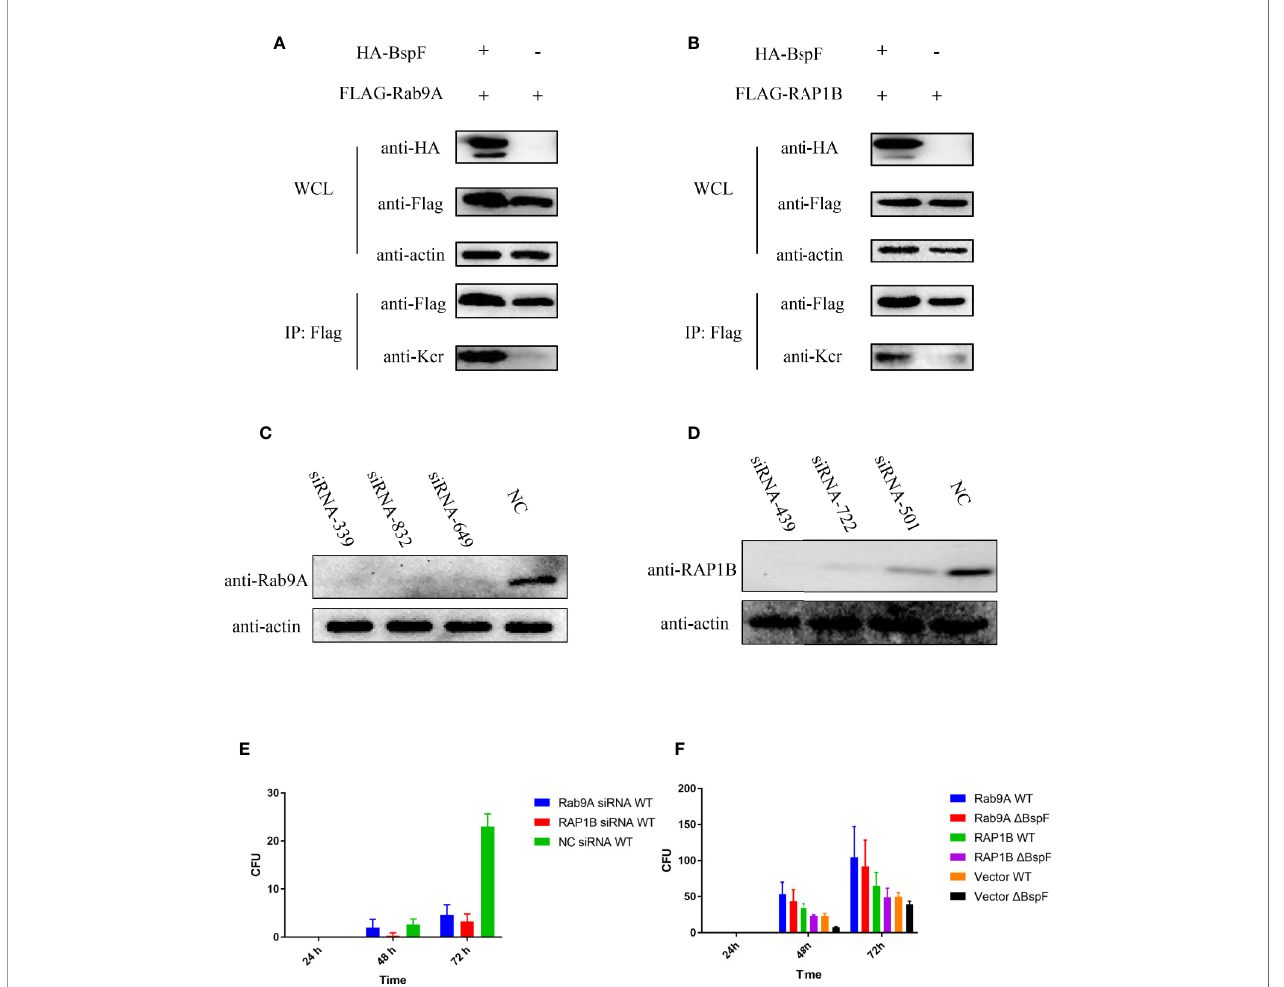
FIGURE 6 | The crotonylated proteins in the crotonylation proteomics data have in fl uence the survival of Brucella. Veri fi cation of the accuracy of proteomics data (A – B) BspF causing the crotonylation of Rab9A and RAP1B. (C – D) Silencing ef fi ciency of siRNA to Rab9A and RAP1B. (E) Silencing of Rab9A and RAP1B gene in HeLa cells, the viability of Brucella is greatly reduced. (F) The overexpression of Rab9A and RAP1B in the cell enhances the ability of Brucella to survive in the